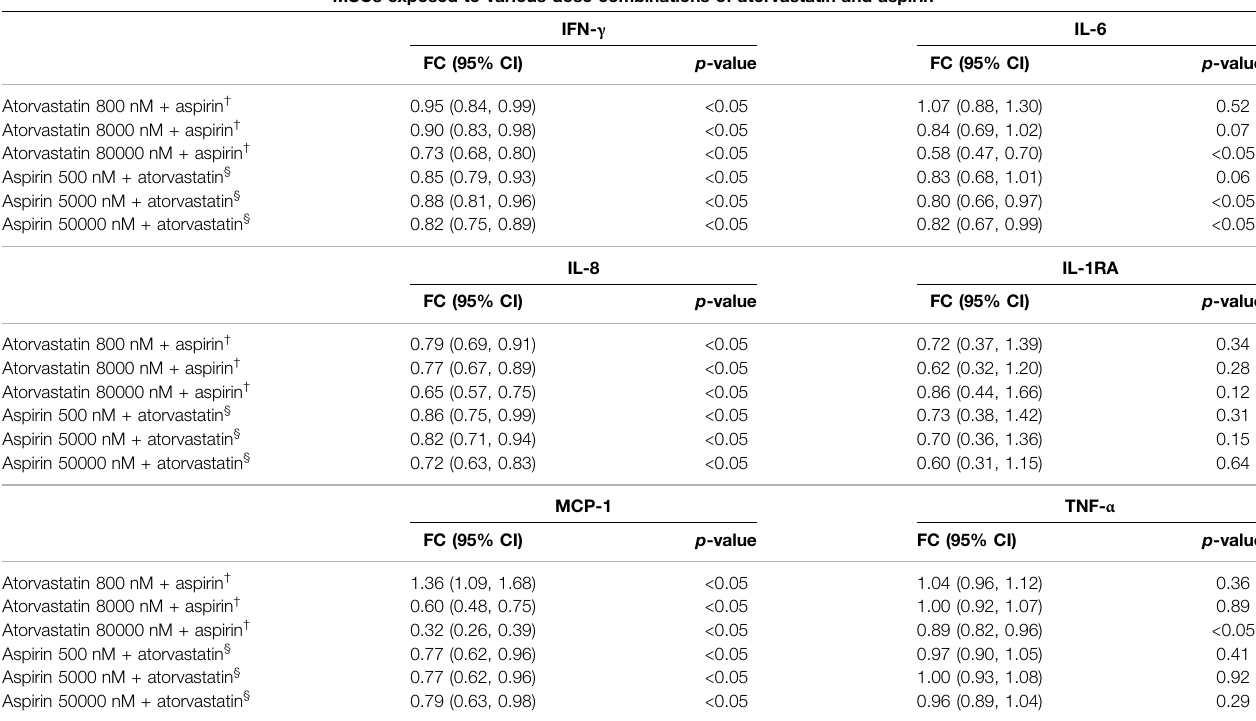
TABLE 2 | Estimated fold changes to secretome from MSCs after exposure to combination of atorvastatin and Aspirin with respect to a vehicle control of atorvastatin 0 + Aspirin 0 nM.Combination ofatorvastatinand Aspirin decreases the IFN- γ , IL-8, and MCP-1 secretions from MSCs at all dose combinations after 24 h ofexposure. In addition, there is also a decrease in IL-6 secretions from MSCs at the highest doses of atorvastatin and aspirin after 24 h of exposure. Signi fi cance is shown by p -value < 0.05. FC (cid:2) Fold Change, 95% CI (cid:2) 95% Con fi dence Intervals with lower and upper limits. MSCs exposed to various dose combinations of atorvastatin and